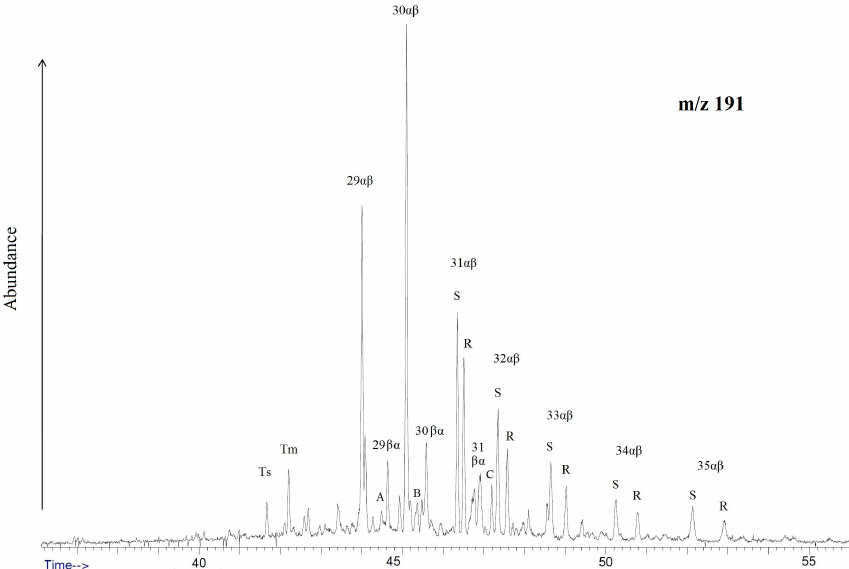
Fig. 5. Characteristic ion fragmentogram ( m/z 191). Numerals refer to carbon numbers of hopane series; αβ = 17 α (H),21 β (H)-hopanes; βα = 17 β (H),21 α (H)-hopanes; S and R = C 22 S and R configuration; Ts: 18 α (H)-22,29,30-trisnorneohopane; Tm: 17 α (H)-22,29,30- trisnorhopane; (A) hop-17(21)-ene; (B) hop-13(18)-ene; (C) 17 β (H)-hop-22(29)-ene